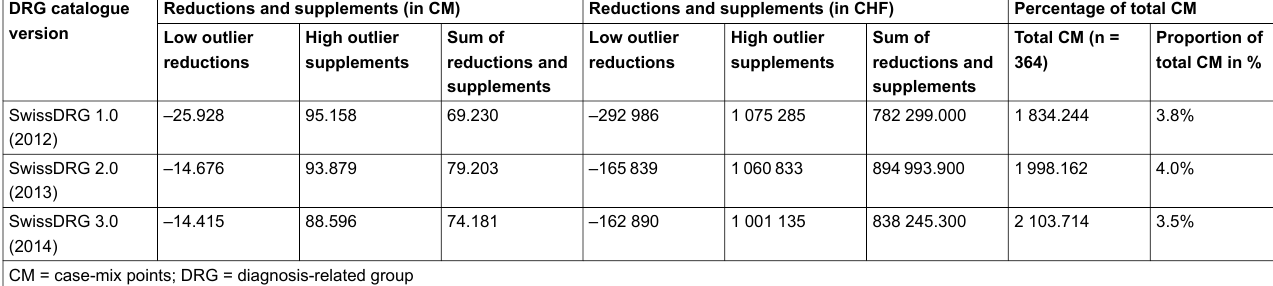
Table 5: Development of low outlier reductions and high outlier supplements in case mix points and in CHF (base rate 11300) under SwissDRG versions 1.0, 2.0 and